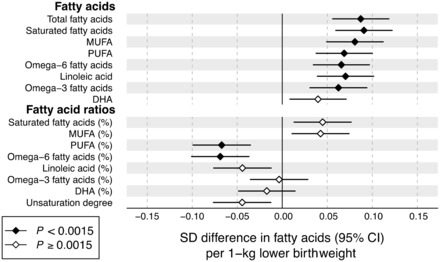
Birthweight associations with adult fatty acid levels. The associations were adjusted for sex, gestational age and age at blood sampling, and meta-analysed for 18 288 individuals from seven cohorts. Association magnitudes are in units of 1 SD fatty acid measure per 1 kg lower birthweight. Fatty acid ratios are relative to the total fatty acid concentration. Error bars denote 95% confidence intervals. Filled diamonds indicate P < 0.0015. Results for individual cohorts are shown in Figure S5, available at IJE online. MUFA, mono-unsaturated fatty acids; PUFA, polyunsaturated fatty acids; DHA, docosahexaenoic acid.